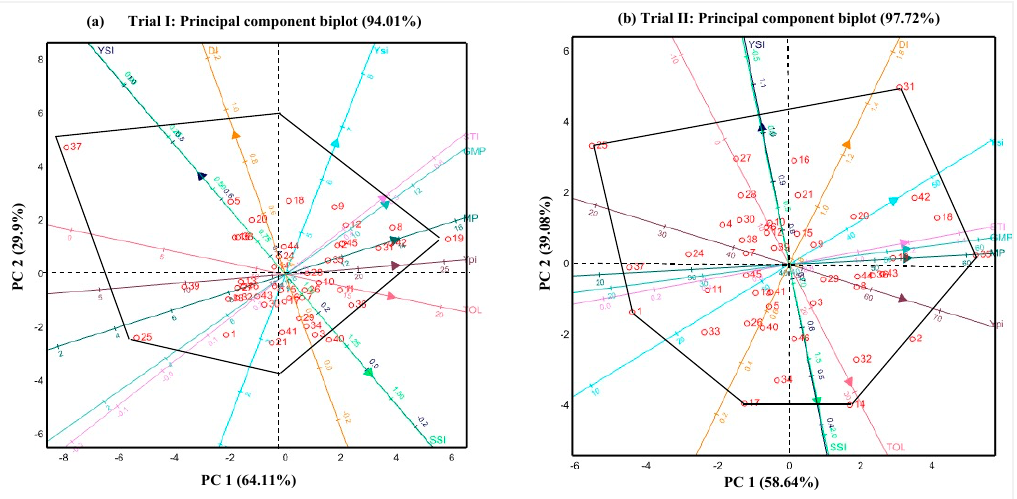
Figure 3. Principal component biplot grouping for drought tolerance indices in ( a ) Trial I and ( b ) Trial II.